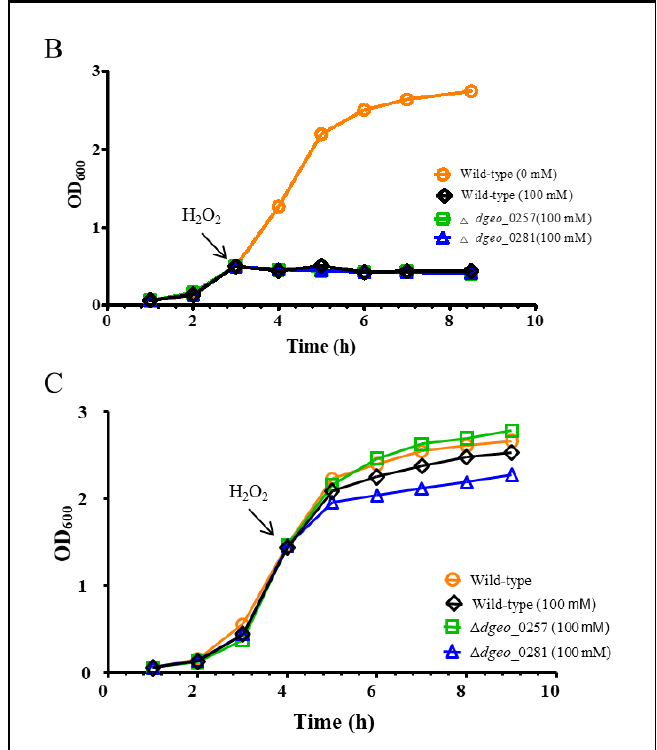
Figure 5. ( A ) Viability against H 2 O 2 treatment at 80, 100, and 120 mM for 1 h was tested. Comparison of growth patterns among wild-type, Δ dgeo _0257, and Δ dgeo _0281 mutant strains. Growth was completely inhibited by 100 mM H 2 O 2 at two different OD 600 values of 0.5 ( B ) and 1.47 ( C ) in wild-type and Δ dgeo _0257 and Δ dgeo _0281 mutant strains. The OD values were determined by direct measurement.